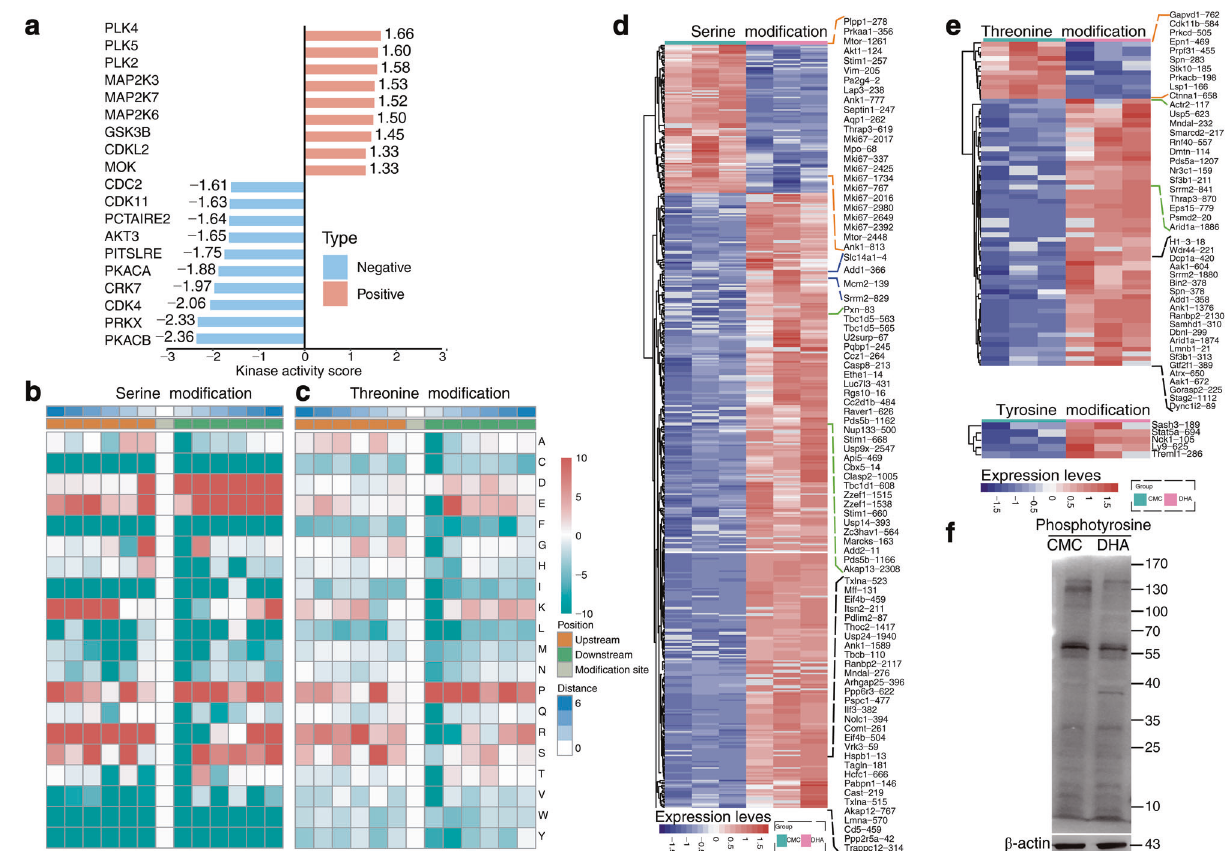
Fig. 4 DHA-induced phosphorylation of MAPKs. a Analysis of the kinase activity between DHA to CMC group, where red indicates no inhibition (high kinase activity), blue indicates kinase inhibition (low kinase activity). b , c The motif enrichment heatmap of up-stream and down-stream amino acids of all identi fi ed modi fi cation sites. Red indicates that the amino acid is signi fi cantly enriched near the modi fi cation site and green signi fi cantly reduced near the modi fi cation site. d , e Heatmaps for visualizing are composed of the signi fi cant differentially modi fi ed sites between DHA and CMC group. f Western blot probed with a monoclonal anti-phosphotyrosine antibody to reveal the differences in protein phosphorylation between DHA-treated and untreated samples. DHA = dihydroartemisinin group, CMC = CMC (carboxymethyl cellulose) solvent solution control